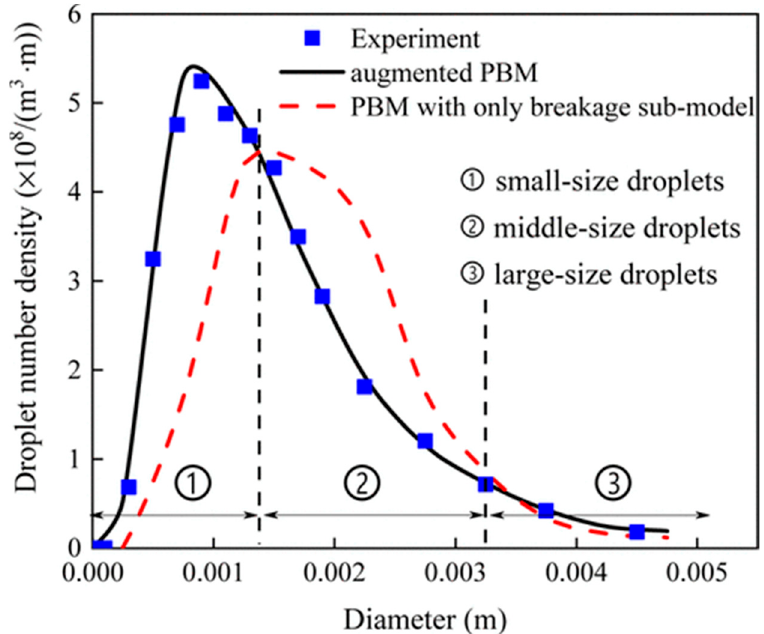
Figure 1. Droplet behaviors in a p ulsed disc-and-doughnut column with wettable internal plates [44].